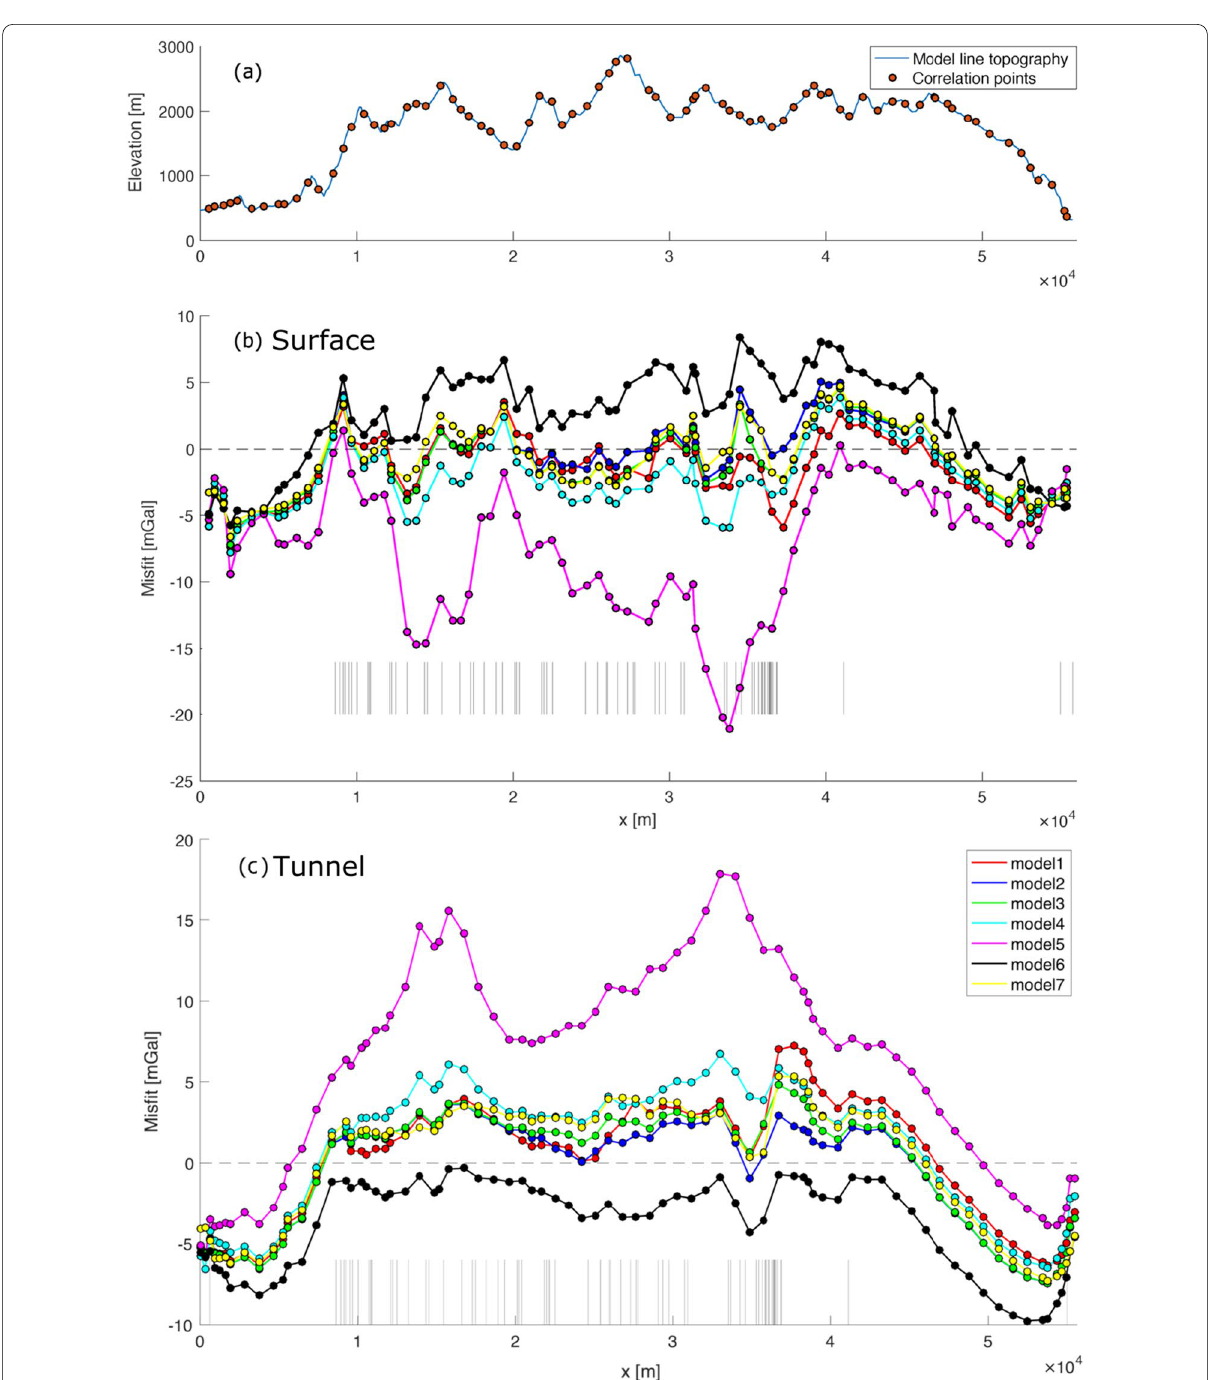
Fig. 8 Misfit profiles between modelled and synthetic gravity anomalies, considering different density models. a The topographic profile along the reference model line (blue line), together with the projected gravity data points at the surface (orange points). These points have been used to sample the topographic profile and compute the cross-correlation between topography and misfit. b Point-wise misfit for the surface gravity data points, for each of the tested density models (see colour legend), as described in Sect. 2.2. Black thin lines in the lower part of the figure, indicate the location of the geological unit boundaries at the surface, along the profile. The point-wise misfit represented in the figure is defined as synthetic minus observed gravity value. c Same as b for the tunnel